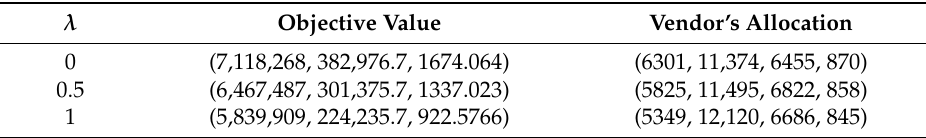
Table 9. Compromise objective value and allocation for case 2 with fixed demand.